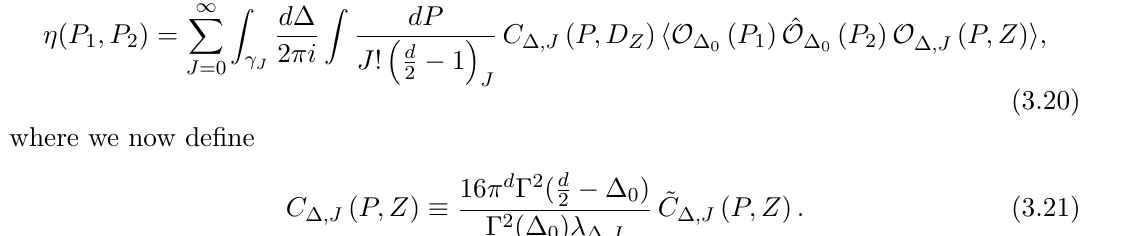
Figure 1 . The deformation of the contour γ 0 from the principal series Re (∆) = d ∆ = 2∆ and exclude d − 2∆ , when 2∆ 2 . In general we should deform the contour γ 0 0 0 < d/ any 2∆ + 2 n + J < d and n = 0 , 1 , · · · 0 2